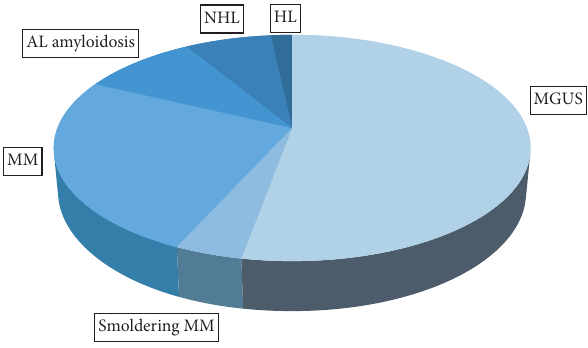
Figure 1: Distribution of monoclonal gammopathy in our cohort of patients. Table 3: Clinical characteristics and lab examinations of patients with monoclonal gammopathy.